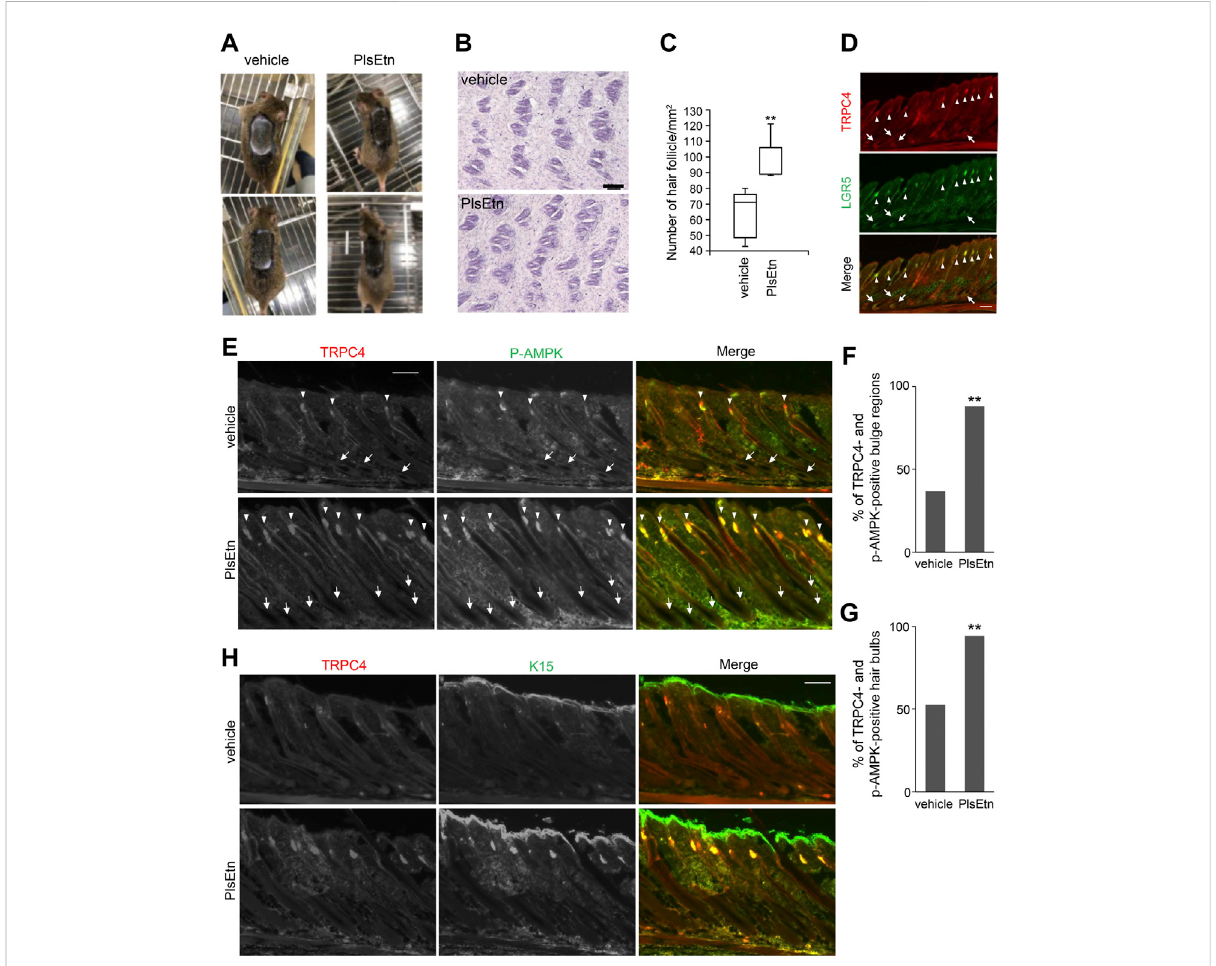
FIGURE 5 PlsEtn activate cells in bulge and hair bulb, leading to hair growth stimulation (A) PlsEtn induce hair regeneration. Eight-week-old male C3H/ HeN mice were shaved and topically applied with vehicle (left) or 10 mg/ml PlsEtn (right) daily for fi ve days a week. Photographs were taken on day 14 post-treatment. Number of animals: vehicle, n = 5; PlsEtn, n = 3. Interestingly, 10 mg/ml PlsEtn generated similar results to 5 mg/ml (SupplementaryFigureS4) (B) HematoxylinandeosinstainingindorsalskintreatedwithvehicleorPlsEtn(10 mg/ml) (C) Numberofhairfollicles per mm 2 counted in fi ve skins from mice treated with vehicle ( n = 2) and PlsEtn ( n = 2), respectively. Statistical analysis was performed by Wilcoxon rank sum test (D) Localization of TRPC4 and LGR5 in unshaved dorsal skin. The hair bulges and hair bulbs where TRPC4 and LGR5 localize are indicated by arrow heads and arrows, respectively (E) Immuno fl uorescence signals of p-AMPK and TRPC4 in dorsal skin treated with vehicle (upper panels) or 5 mg/ml PlsEtn (lower panels). TRPC4- and p-AMPK-positive hair bulbs and bulges are indicated by arrows and arrow heads, respectively (F) PercentagesofTRPC4-andp-AMPK-positivebulgeindorsalskinofmicetreatedwithvehicle( n =3)or5 mg/mlPlsEtn( n =3).Morethan200hair bulges were randomly counted in each condition. Statistical analysis was performed by χ 2 test (G) Percentages of TRPC4- and p-AMPK-positive hair bulbs in the dorsal skin of mice treated with vehicle ( n = 3) or 5 mg/ml PlsEtn ( n = 3). More than 200 hair bulbs were randomly counted in each condition. Statistical analysis was performed by χ 2 test (H) Immuno fl uorescence signals of TRPC4 and K15 in dorsal skin treated with vehicle (upper panels) or 5 mg/ml PlsEtn (lower